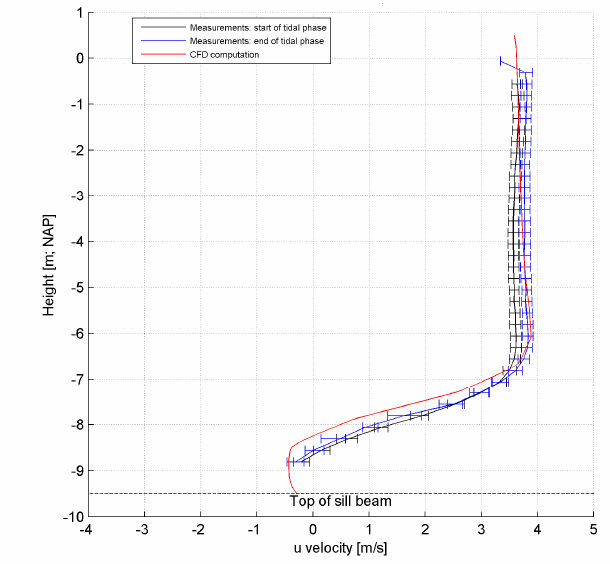
turbines (in blue) and the CFD (in red) – Flood Case NT.4